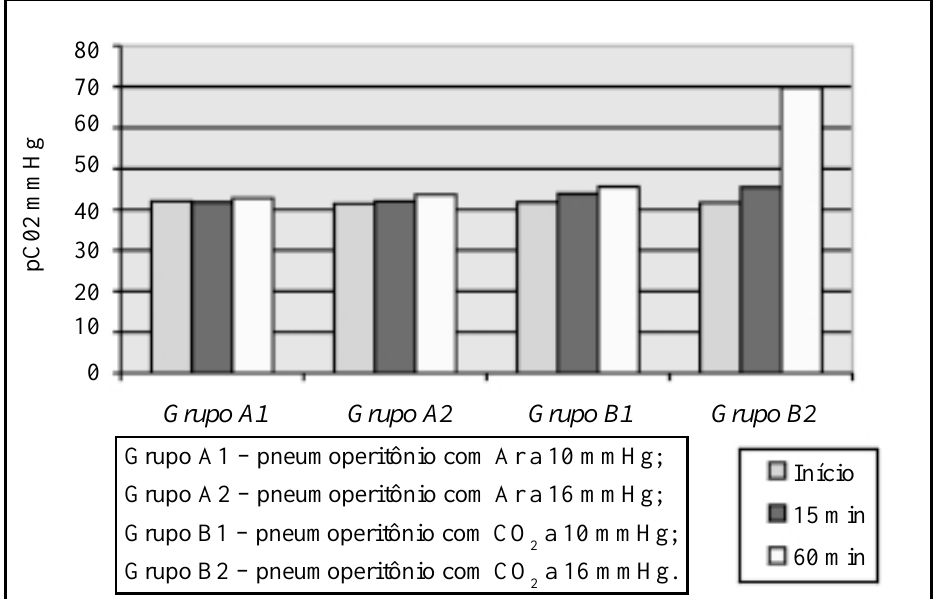
FIGURA 1 – pCO na amostra de sangue venoso central nos grupos A1, A2, B1 e B2: antes da insuflação 2 da cavidade, com 15 min. e 1hora de pneumoperitônio.